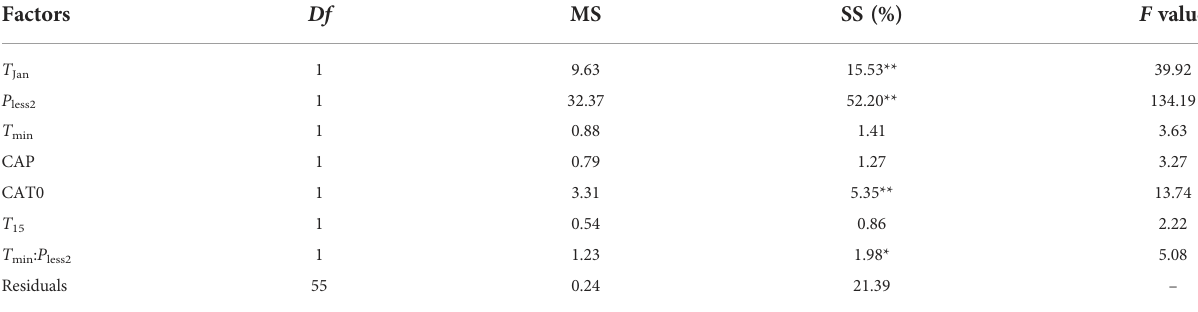
Precipitation of the past years (P past ) was removed before fi tting the regression model because of high multicollinearity (variance in fl ation factor > 10). MS,meansquares;SS,proportionofvarianceexplainedbythevariable;T Jan ,averagetemperatureinJanuary;P less2 ,precipitationoftheyearswithlessprecipitationinthepast2years;T min ,